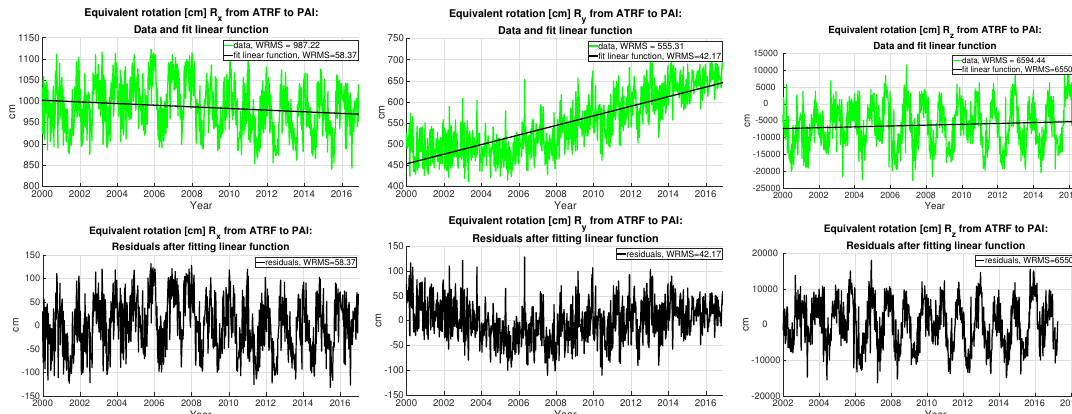
Figure 3. The results derived from the SLR DGFI-TUM Stokes coefficients with weekly resolution: ( top ) equivalent rotations [cm] R x , R y , and R z from ATRF to PAI frame (in green, from left to right) and fit linear functions (in black); and ( bottom ) the residuals are also given in [cm]. Table 3. The results derived from the SLR DGFI-TUM Stokes coefficients with weekly resolution. WRMS after fitting a linear function to each, biases, and drifts of the equivalent rotations R x , R y , and R z from ATRF to PAI. Units are [cm] and [cm/year], time origin is 2000.0. WRMS